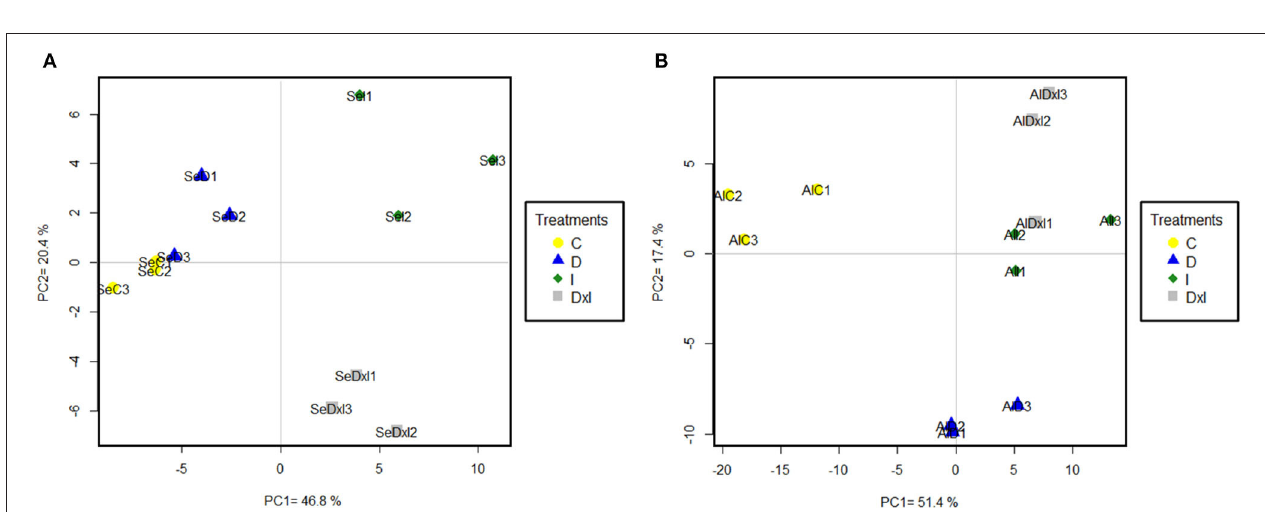
FIGURE 7 | Principal component analysis of variable proteins identified in the Seville (A) and Almeria (B) populations. Treatments: C control; D drought; I inoculation; D × I combined. Numbers indicate biological replicates for each treatment.